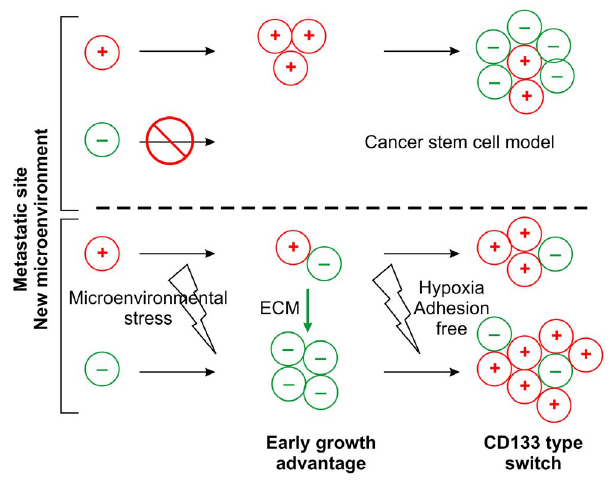
Figure 5. Hypothetical model of early tumor colonization in metastatic lesions. Upper panel shows conventional CSC model, in which only CD133 + colon cancer cells colonize at the metastatic site before differentiating into CD133 2 cells during tumor growth. Lower panel shows the hypothetical model, in which both CD133 + and CD133 2 cells colonize at the metastatic site and in which CD133 2 cells have greater colonization capacity. While ECM stimulation promotes switching of CD133 + cells to CD133 2 cells in the early phase of colonization, exposure to hypoxia and 3D architecture after coloniza- tion induces switching of CD133 2 cells to CD133 +